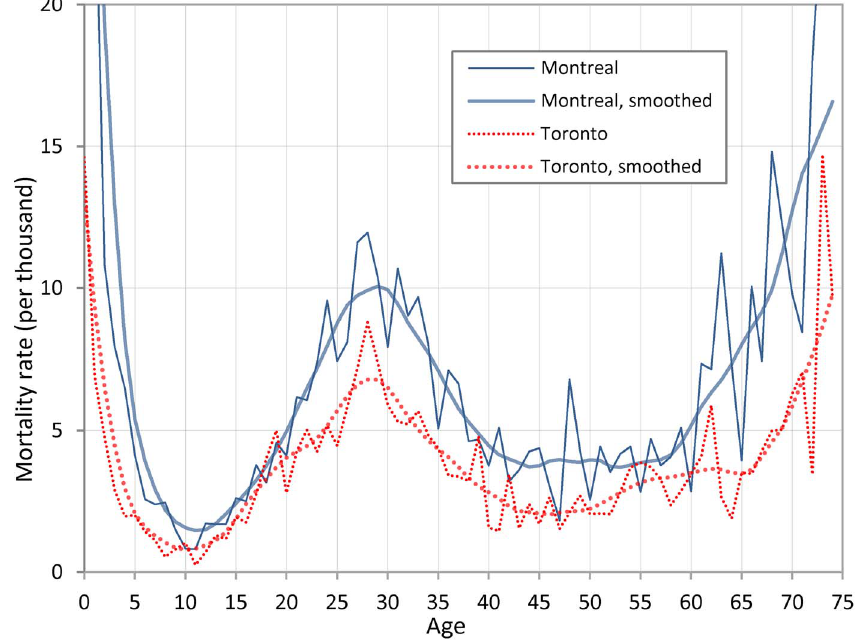
Figure 2. Death rates (from all causes) by age in Montreal and Toronto during the month of October, 1918.